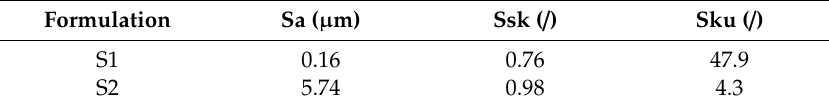
Table 2. Statistical surface parameters of S1 and S2.